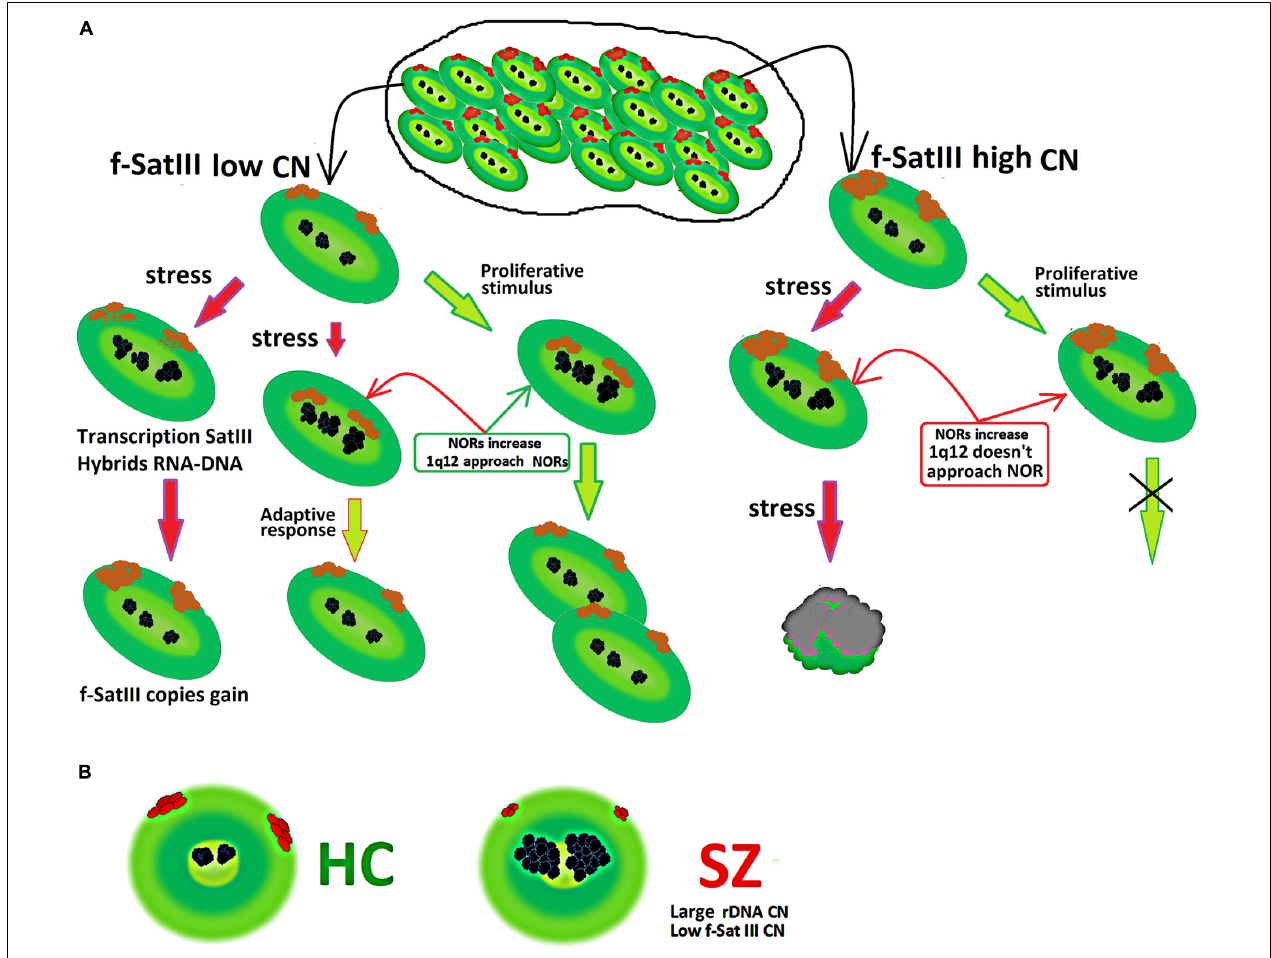
FIGURE 6 | (A) Scheme showing a change in the content of f-SatIII in a cell population under stress. A detailed description is given in the text. (B) Illustration of f-SatIII and rDNA tandem repeats sizes in HC and SZ